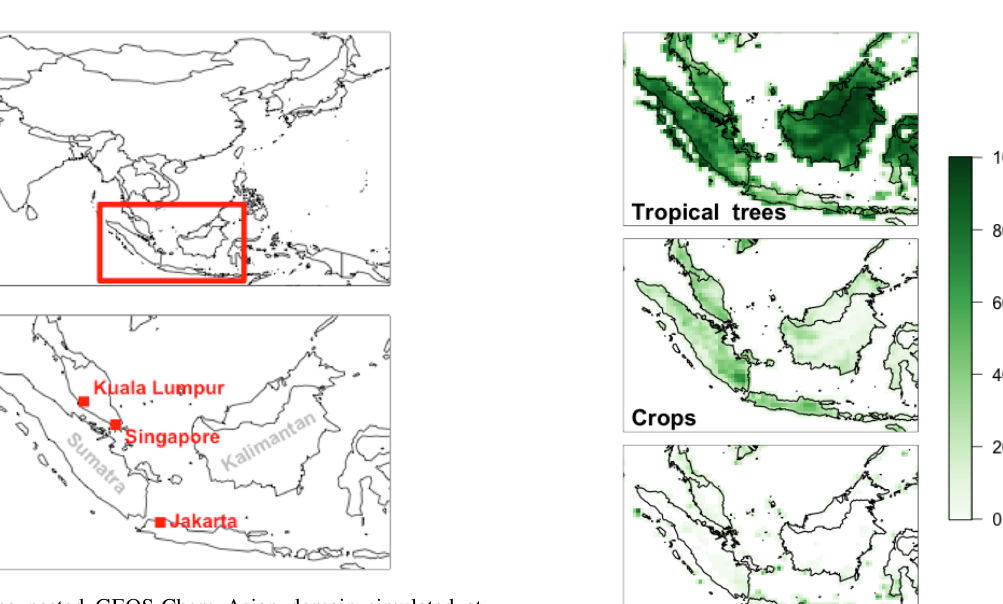
Figure 1. The nested GEOS-Chem Asian domain simulated at 0.5 × 0.67 (top) and the particular region of interest explored in this work (bottom). The location of major regions discussed in the text are also shown. Figure 2. Percentage of vegetated area occupied by dominant veg-